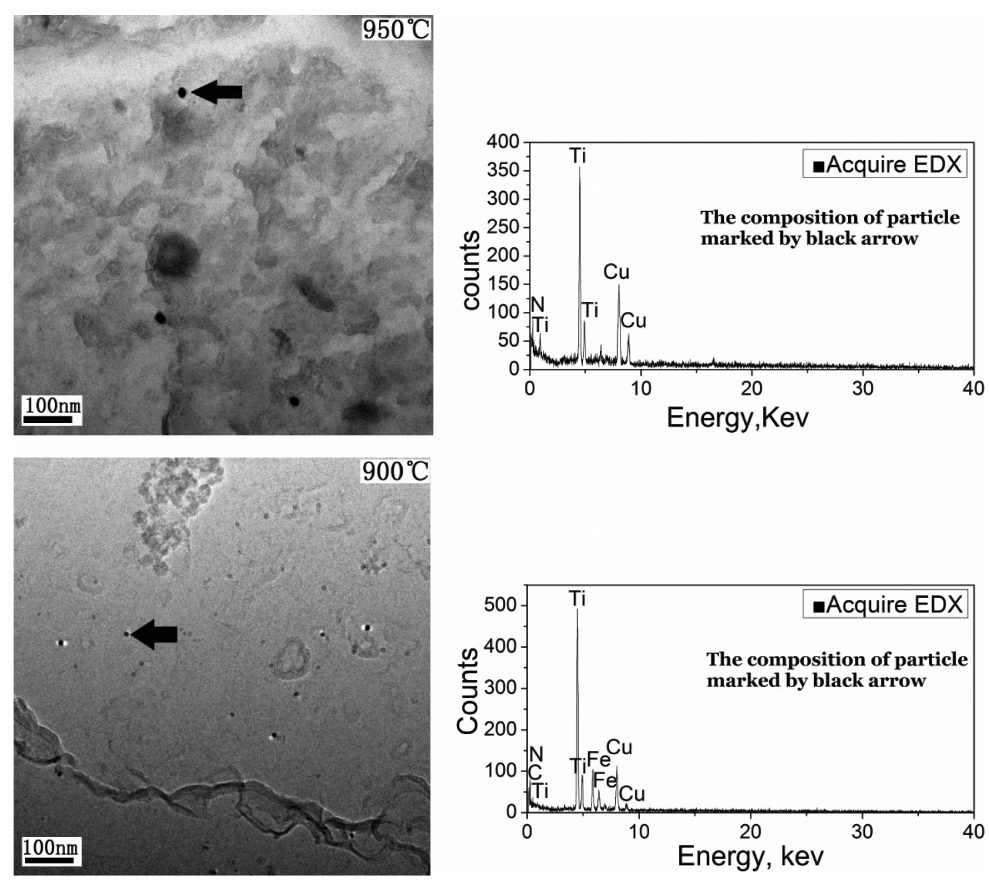
Fig. 8: TEM replica micrographs and corresponding EDX spectra at 950 °C and 900 °C in Ti-bearing steel.